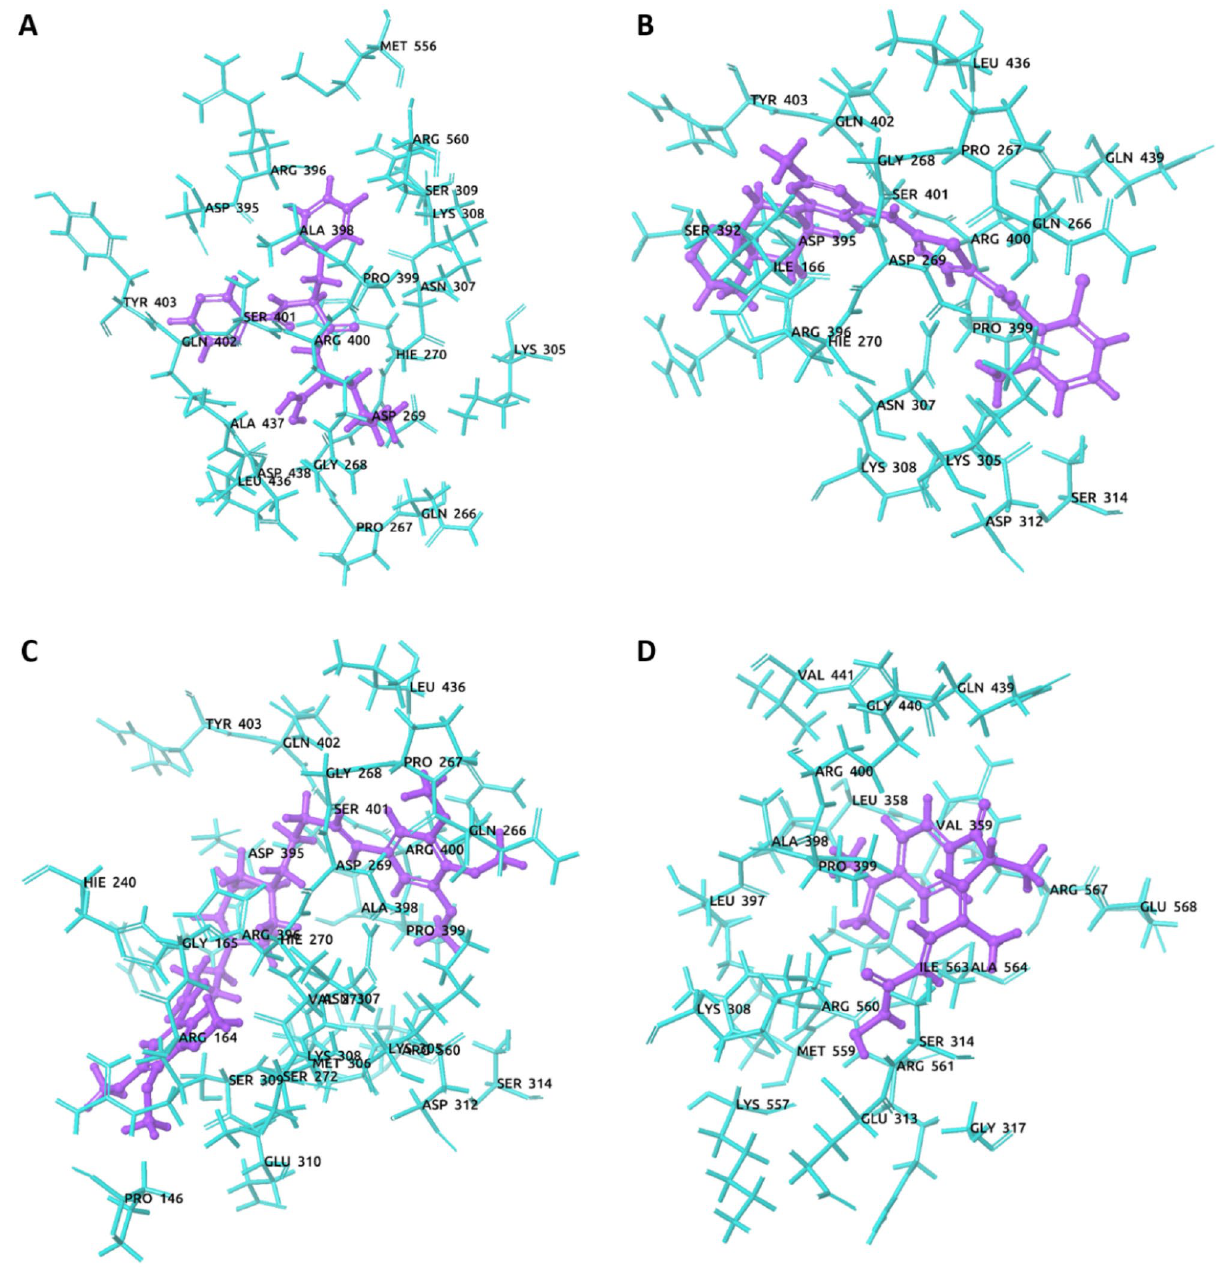
Figure 5. The 3D interaction between MCM7 protein and selected compounds complex structure. (A) CID_387447, (B) CID_3062316, (C) CID_9874191, and (D) CID_444732 (control). Compounds